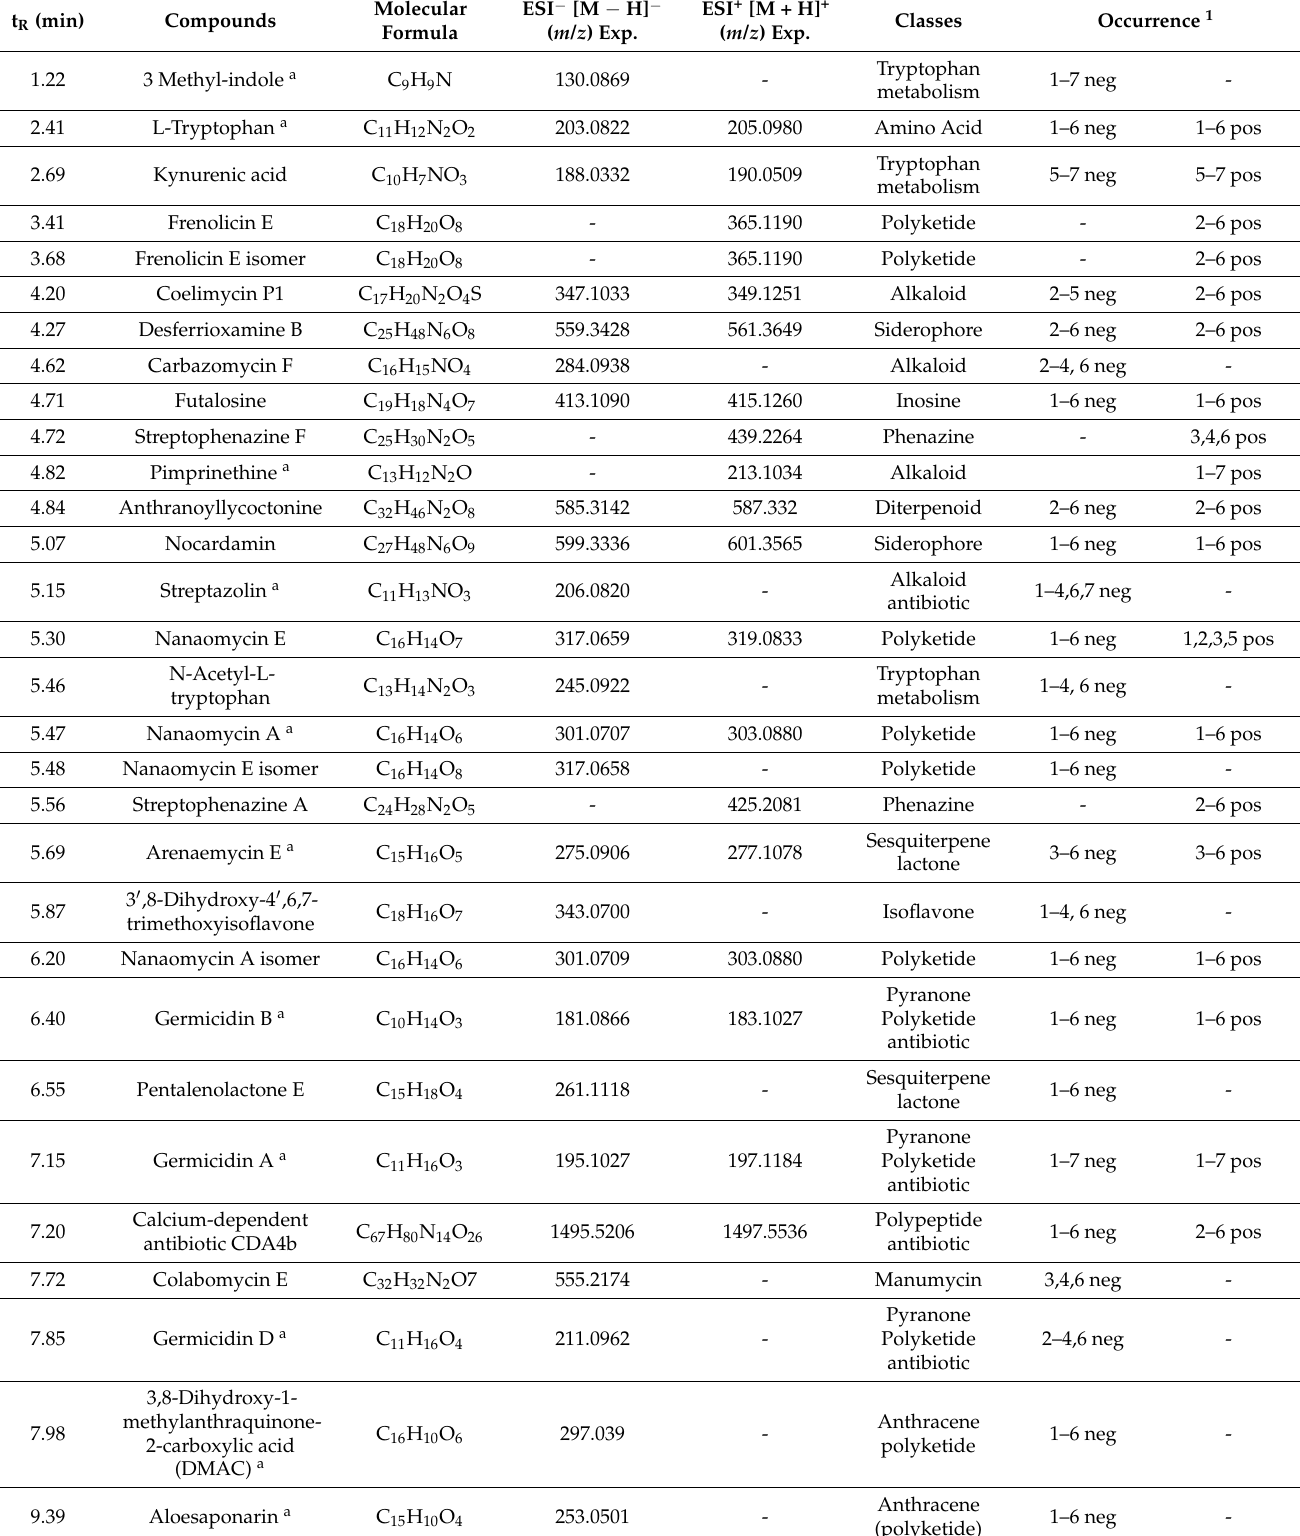
Table 2. Metabolites identified using HPLC/MS/ESI/Q-TOF from spent media of bacterial cultiva- tions and their occurrence in different